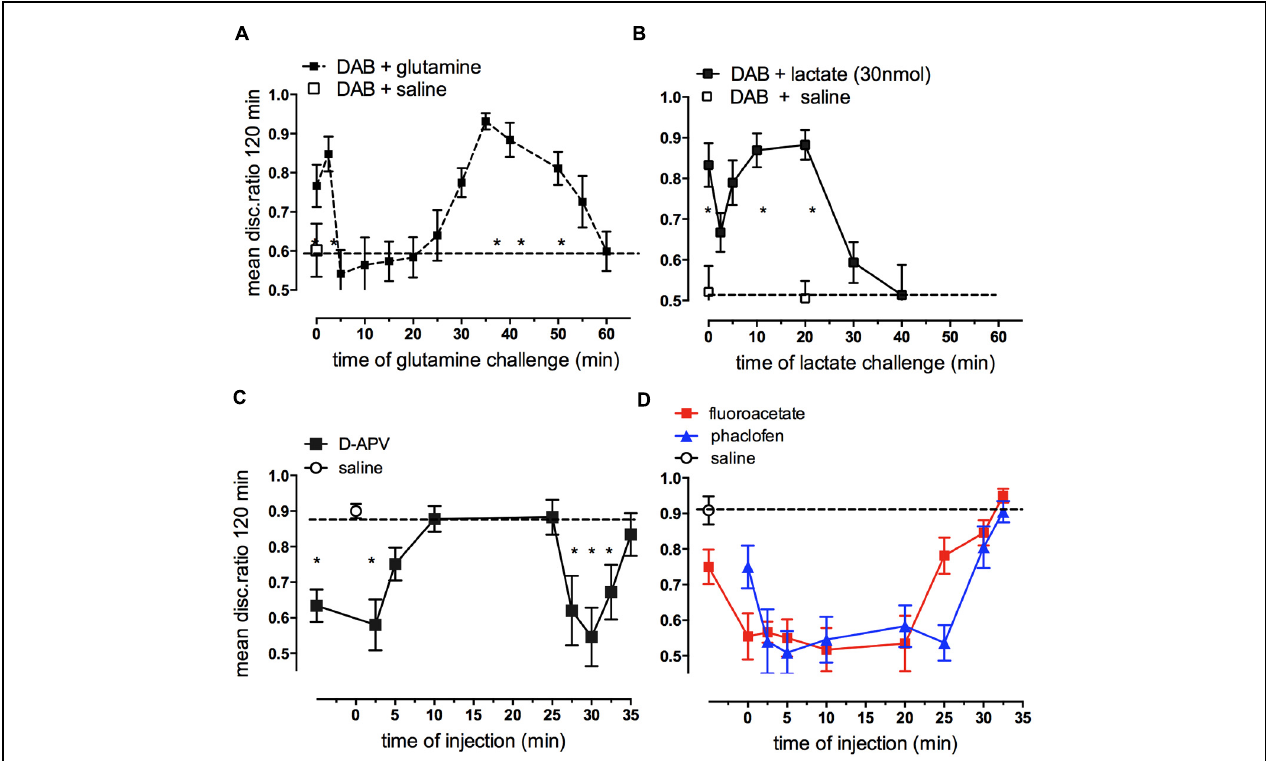
FIGURE 11 | Ability of glutamine or lactate to rescue memory following DAB inhibition of glycogenolysis (A,B) and effect of hippocampal injection of antagonists of NMDA receptors, GABA B receptors or fluoroacetate on strongly reinforced training (C,D). DAB was injected into IMM 5 min before strongly reinforced training and challenged at various times by glutamine (A) or L -lactate (B) (From Hertz and Gibbs, 2009). (C) The NMDA angtagonist D-APV injected into the hippocampus inhibited memory given up to 5 min post-training and again when given 27.5–32.5 min post-training. (D) Both the GABA B receptor antagonist, phaclofen and fluoroacetate inhibited memory when given between 2.5 and 25 min post-training. * P < 0.05. (From Gibbs et al., 2008a; Gibbs and Bowser,